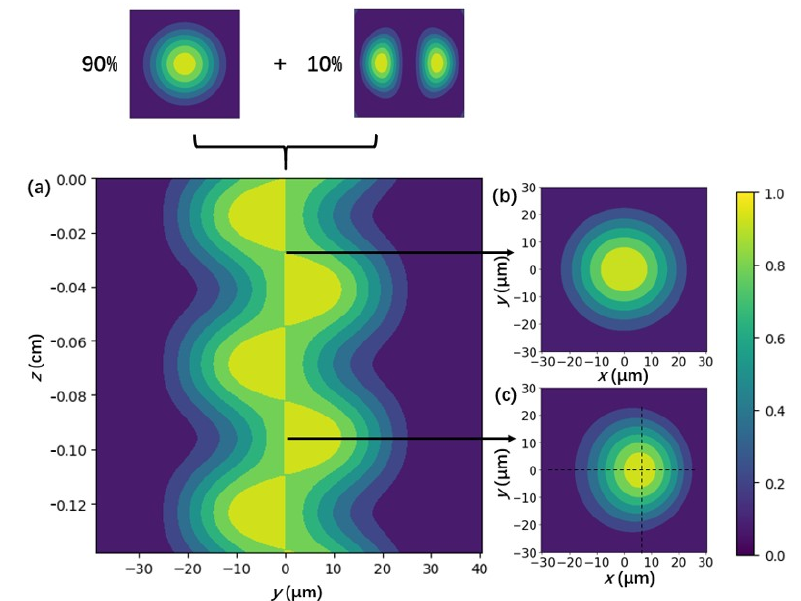
Figure 4. Intensity distribution in the fiber with a superposition of linearly polarized (LP) 01 and LP 11 modes. The power ratio of the LP 01 and LP 11 mode is set to be 9:1. ( a ) Intensity distribution on the y – z plane. The interference of the two modes gives an intensity modulation with a period of difference in the wavenumbers on the z -axis. The origin of the coordinate is set at the upper tip of the fiber; ( b ) and ( c ) are the intensity distribution in the fiber cross-section at different z positions. The position of the peak intensity shifts along the z -axis.